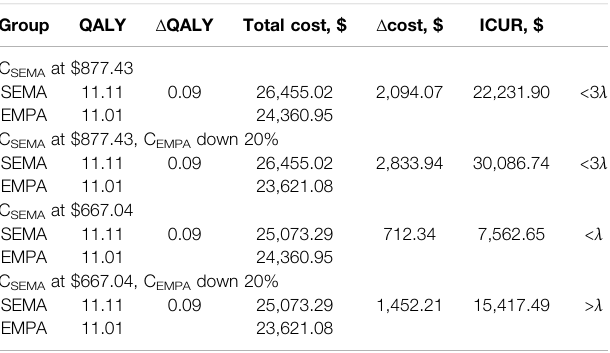
TABLE 8 | The results of scenario analysis on C EMPA